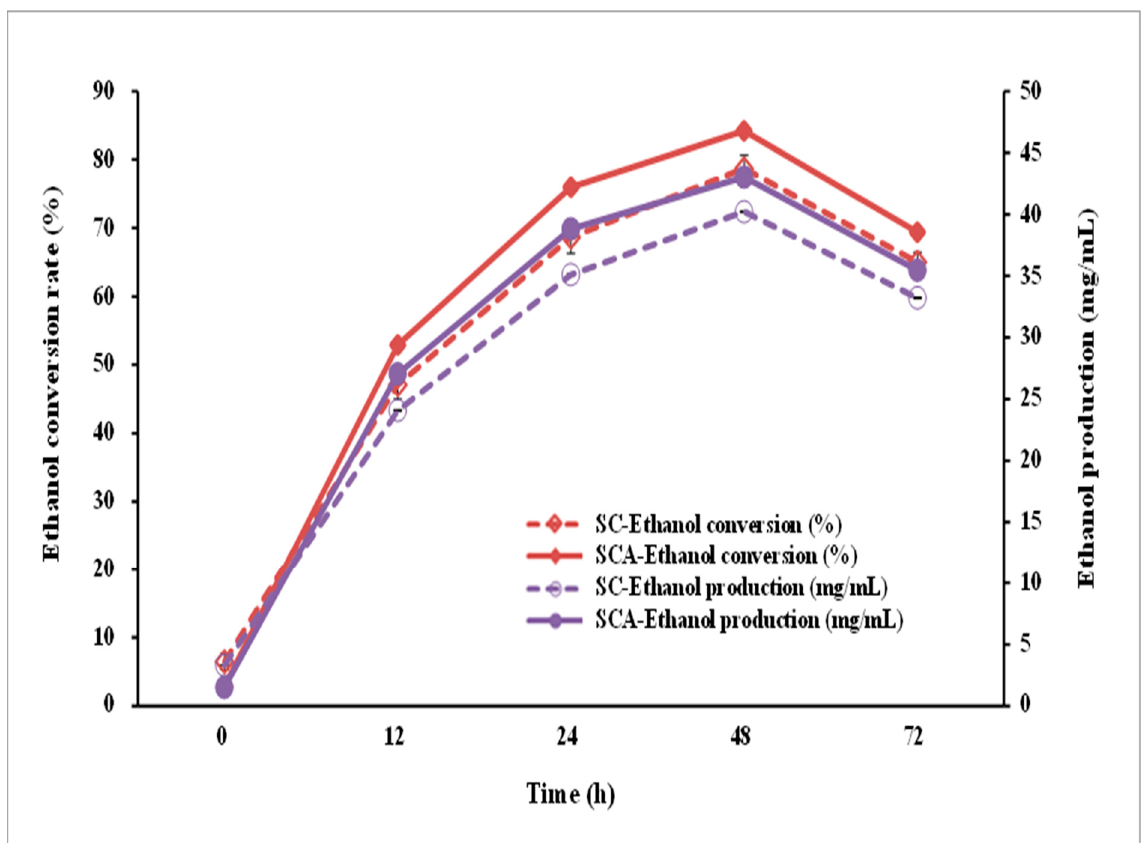
Figure 8. Ethanol conversion rate and production using SCA (filled symbol) and SC (open symbol) in the presence of 10% glucose on the YPD medium. SC ( S. cerevisiae ) and SCA ( S. cerevisiae with ari1 gene overexpression).